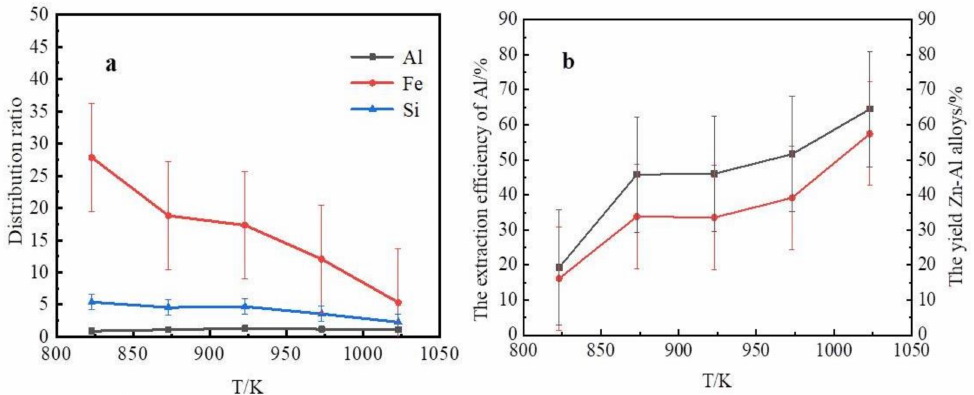
Figure 4. The influence of liquation temperature. ( a ) Curves of the extraction rate and the yield at various liquation temperatures; ( b ) The element distribution ratio of slag to alloy.